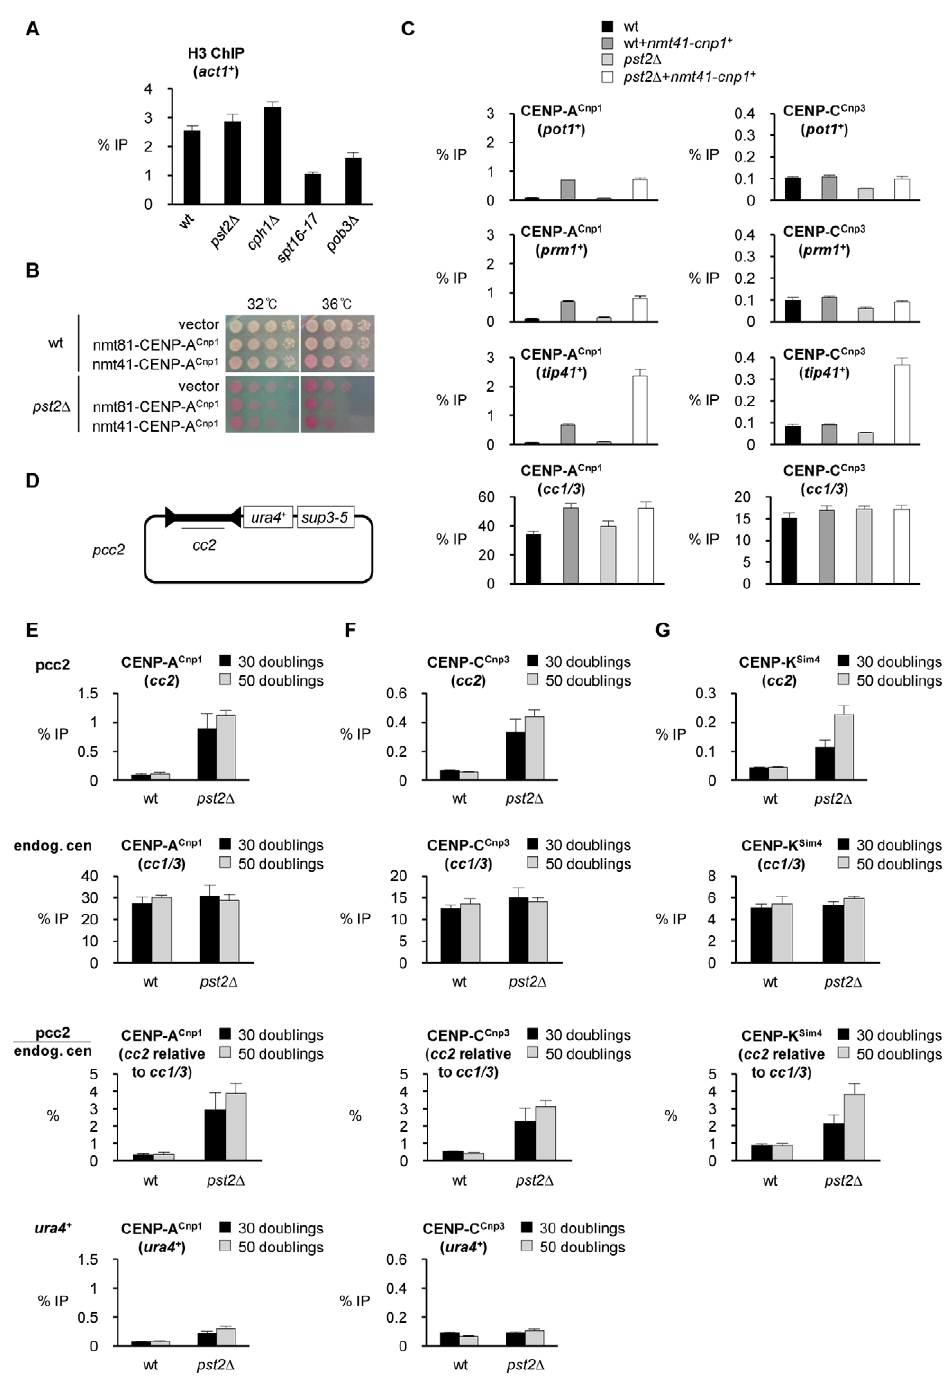
Figure 6. Loss of Clr6-CII function promotes assembly of CENP-A Cnp1 chromatin at specific loci. (A) ChIP analysis of H3 levels at act1 + in the indicated strains grown at 32 u C. Note: spt16-17 (but not spt16-18 ) cells are viable at 32 u C and thus are grown in parallel with other mutants as a positive control in this experiment. (B) Viability of wt and pst2 D cells expressing additional CENP-A Cnp1 at low (nmt81-CENP-A Cnp1 ) or medium (nmt41- CENP-A Cnp1 ) levels compared to empty vector at 32 u C and 36 u C. (C) ChIP analyses of CENP-A Cnp1 and CENP-C Cnp3 levels in wt and pst2 D cells at pot1 + , prm1 + , tip41 + and endogenous centromeres ( cc1/3 ). Cells were grown at 32 u C. (D) Schematic of pcc2 plasmid. pcc2 plasmid contains 8.6 kb cen2 central domain ( cc2 ), ura4 + and sup3-5 . (E) ChIP analysis of CENP-A Cnp1 levels at cc2 in pcc2 plasmid and at endogenous centromere ( cc1/3 ) in wt and pst2 D cells carrying pcc2. The relative enrichment of CENP-A Cnp1 at cc2 compared to endogenous centromere ( cc1/3 ) is presented ( cc2 relative to cc1/ 3 ). Enrichment of CENP-A Cnp1 at ura4 + in pcc2 is also measured. (F) ChIP analysis of CENP-C Cnp3 levels in the same samples. (G) ChIP analysis of Sim4 levels in the same samples. ChIP was performed after 30 and 50 cell doublings at 32 u C from the introduction of pcc2. Enrichment is reported as % IP. Error bars indicate S.D. from at least 3 biological